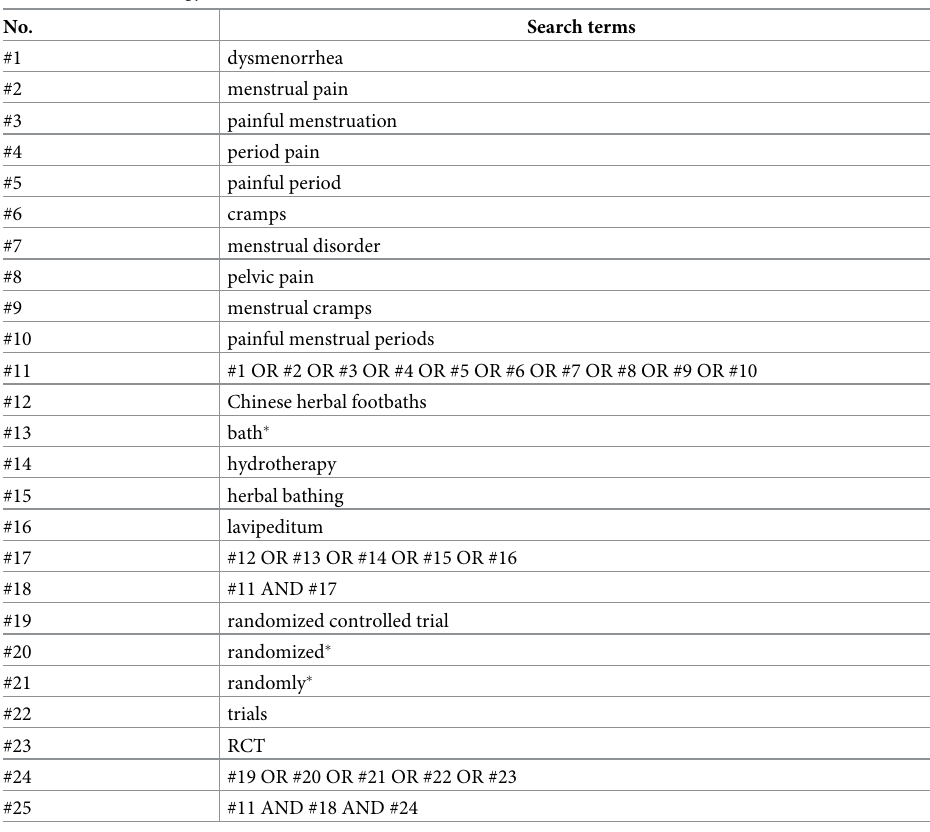
Table 1. Search strategy for the PubMed.